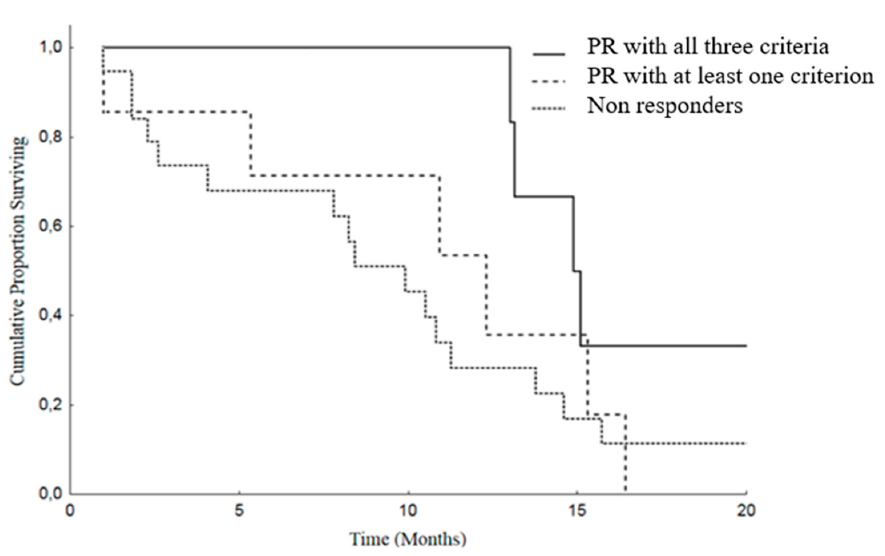
Figure 5. Progression Free Survival (PFS) in patients with PR according to all the three criteria [median 14.9 months (12.5–17.2)] versus PR in one or two criteria [median 12.3 months (4.7–19.8)] versus SD or PD (in all 3 criteria)[median 9.9 months (6.8–12.9)], p = 0.107.